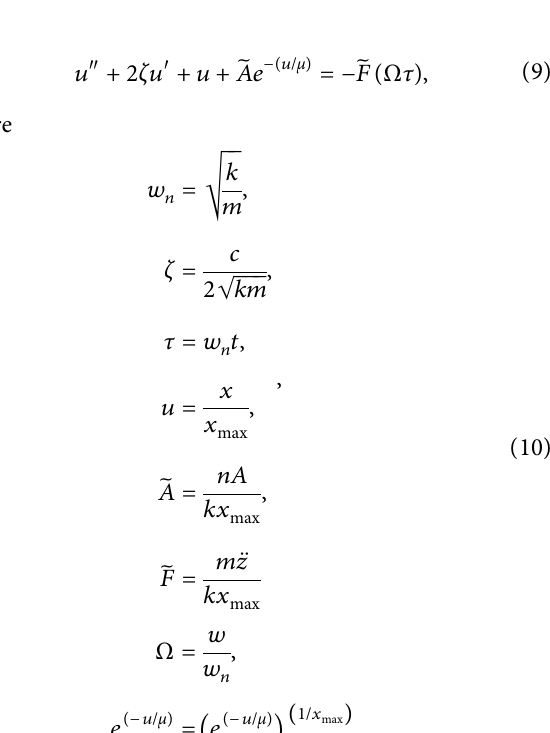
Figure 1: Modeling of the NSA prototype as a spring-mass